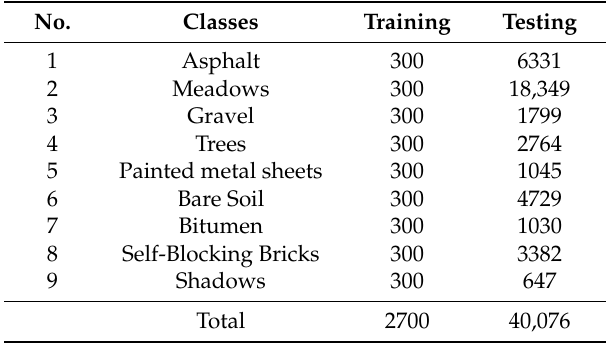
Table 3. Number of training and testing samples used in the Pavia University